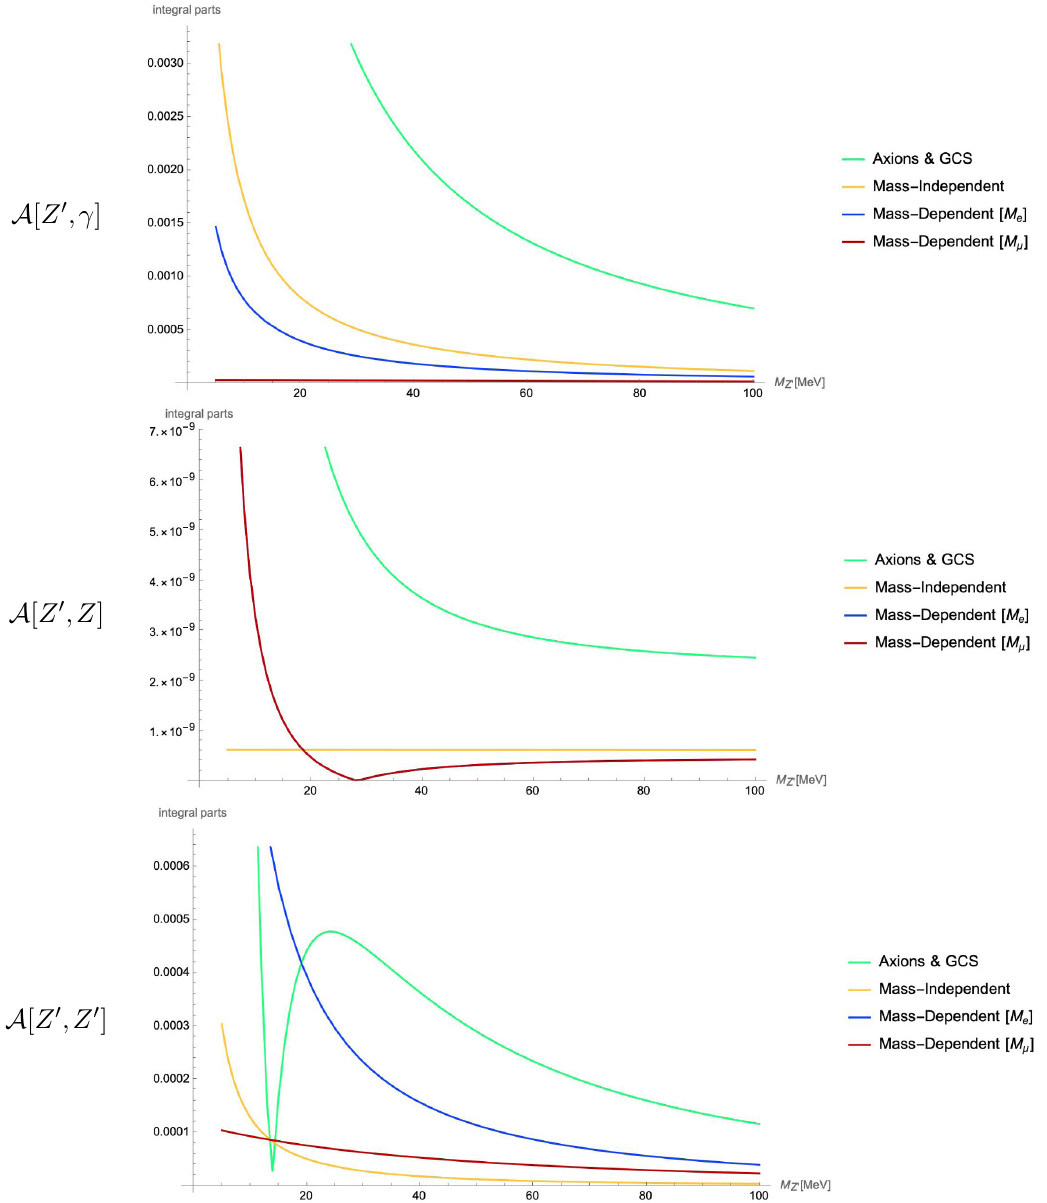
Figure 6 . In these plot we compare the absolute value of the contribution coming from the amplitudes A [ Z 0 ,γ ] , A [ Z 0 ,Z ] , A [ Z 0 ,Z 0 ] excluding the anomalies t q f − A i ’s, and splitting them in the Axionic and GCS, the mass-independent and the mass-dependent contributions (for the fermion in the loop to be the electron or the muon f = e/µ